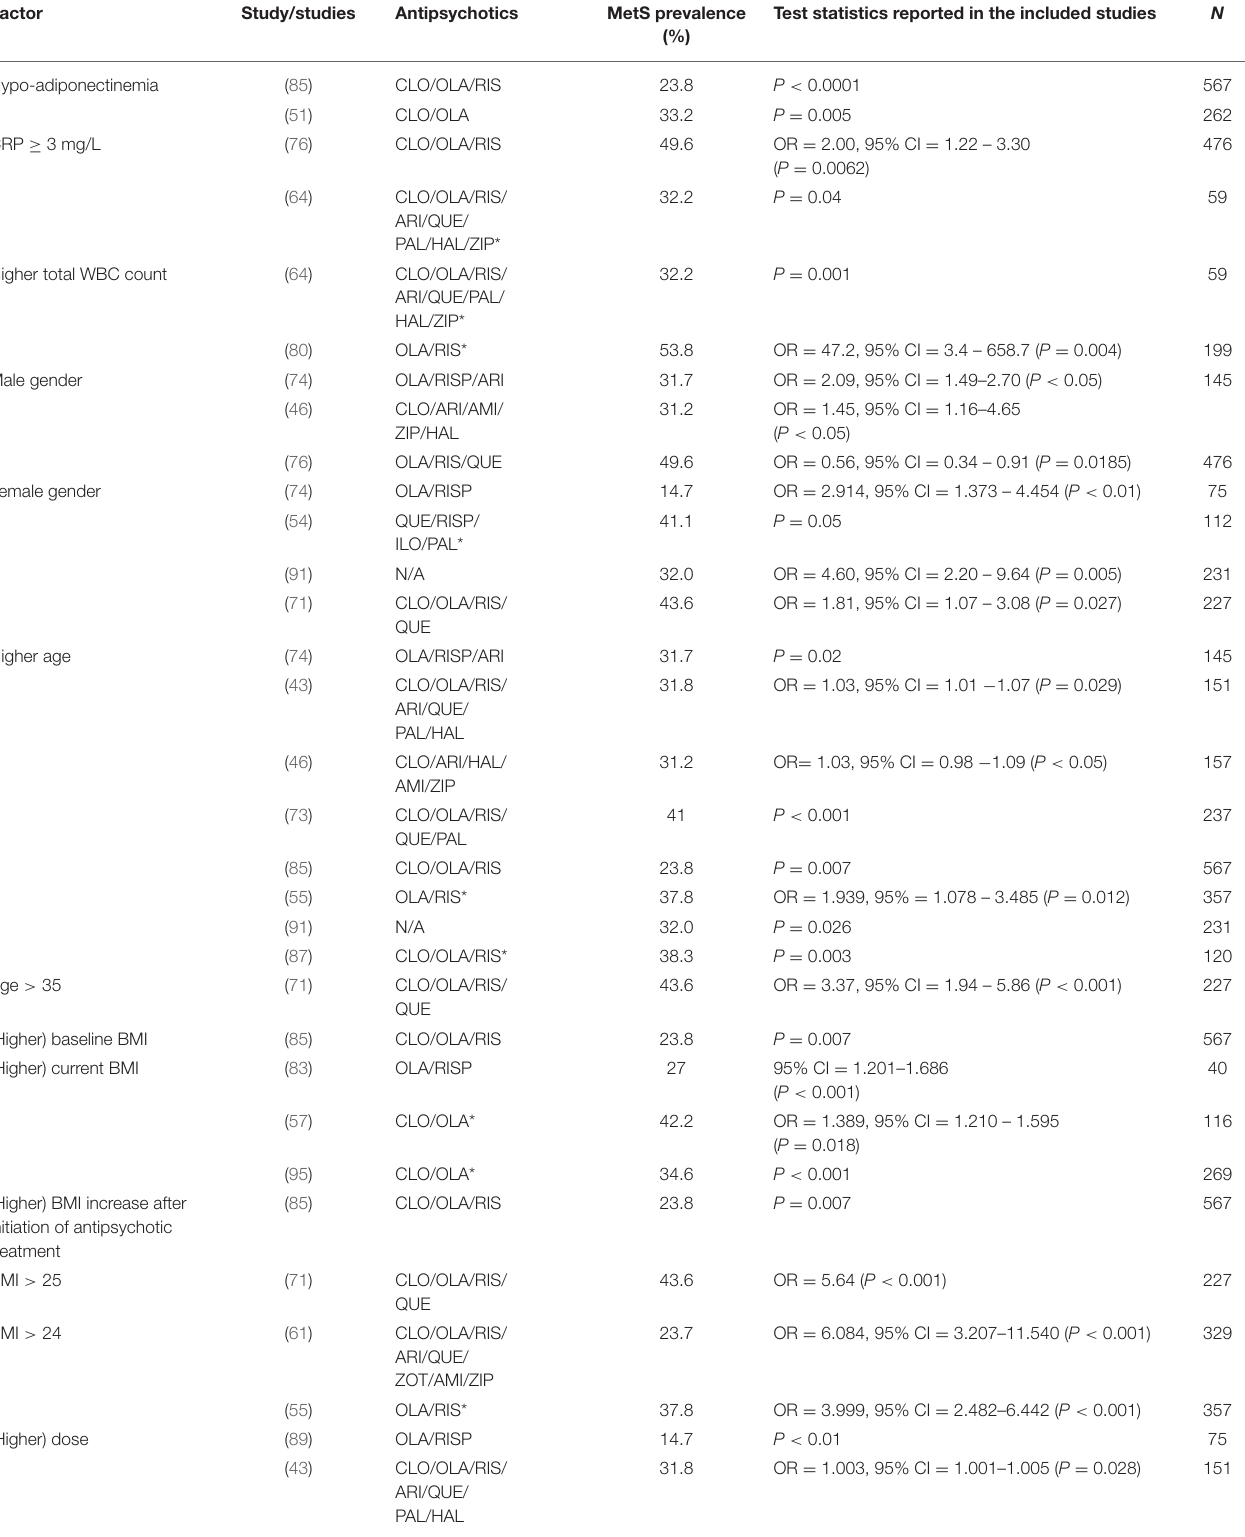
TABLE 3 | Results regarding factors which were associated with MetS in pooled